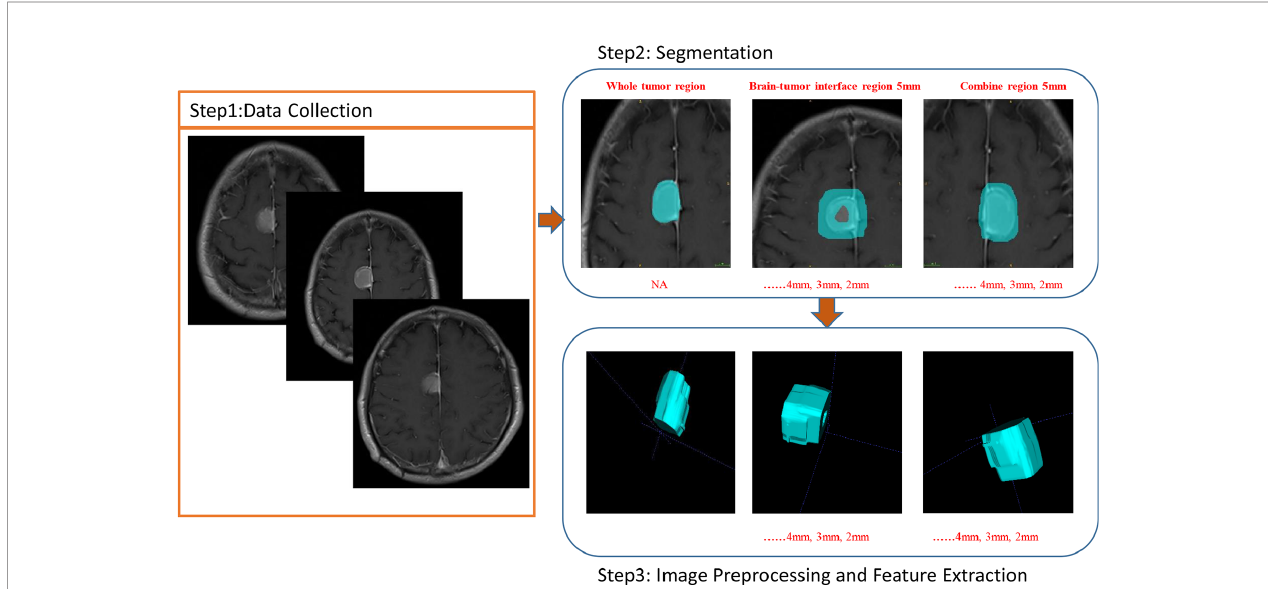
FIGURE 2 | Images show the BTI, WT, and Com radiomics of invasive meningioma at CE-T1W MR